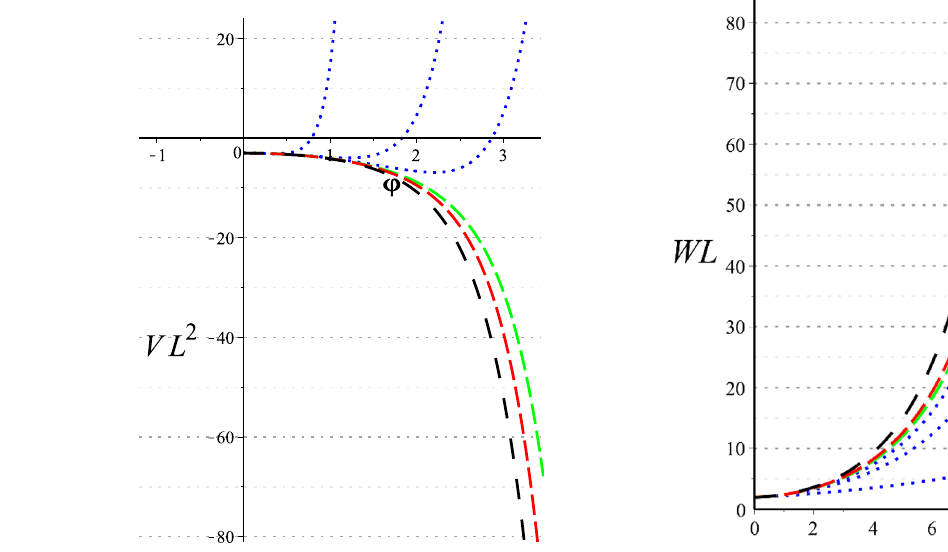
Figure 2 (a). Plot of the dilaton poten- tial vs. ϕ ≥ 0 , for ν = 1 . 1 , 1 . 6 , 1 . 9 , 2 . 1 , 2 . 2 , 2 . 7 . There are no black holes for the dot-blue curves ν = 1 . 1 , 1 . 6 , 1 . 9 .